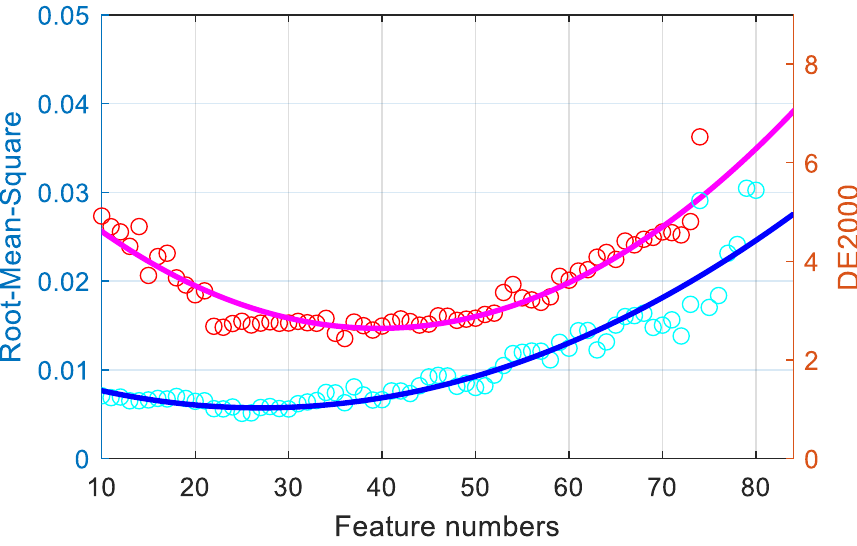
Figure 4. Relationship of the feature numbers with the spectral and color performance.